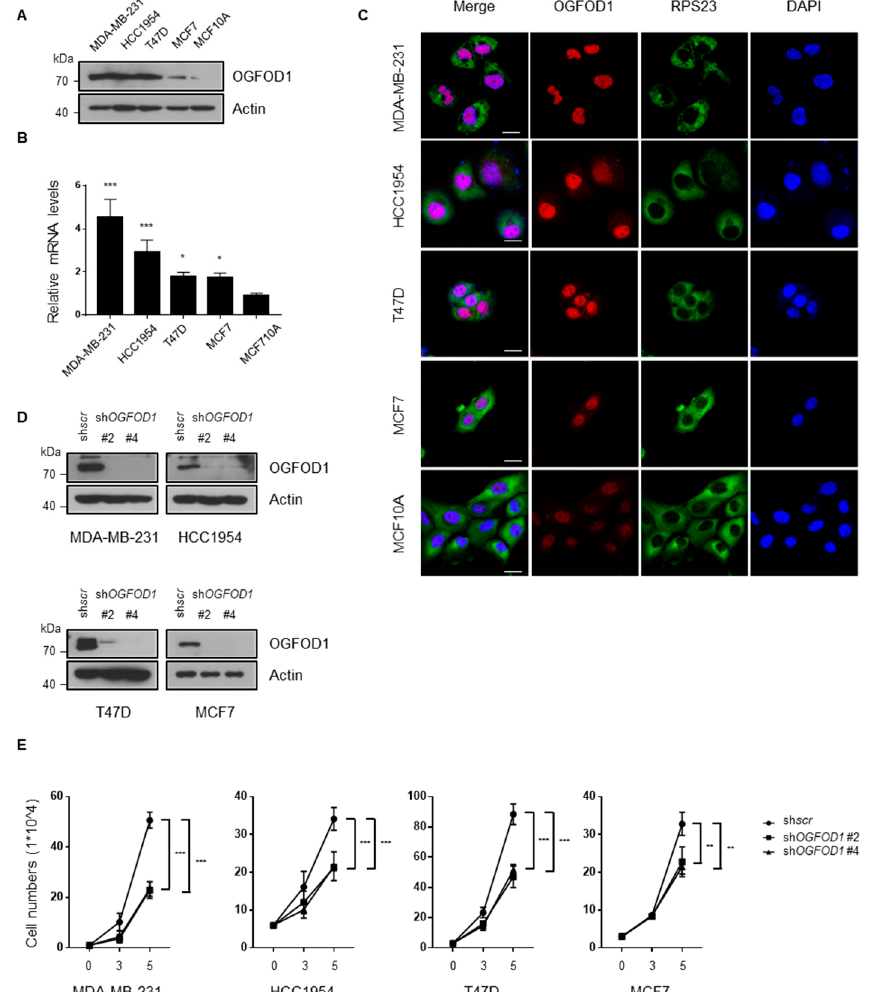
Figure 1. High level of OGFOD1 is important for proliferation. ( A , B ) Protein and mRNA levels of OGFOD1 in breast cancer cell lines and non-tumorigenic epithelial cell line. Protein levels were confirmed using Western blot assay. mRNA levels were compared using qRT-PCR. ( C ) Confocal images of OGFOD1 and RPS23 in breast cancer cell lines. OGFOD1 was stained with Alexa 568 (red), RPS23 was stained with Alexa 488 (green) and nuclei were stained with DAPI (blue); scale bar indicates 20 µ m. ( D ) OGFOD1 knockdown in breast cancer cell lines. OGFOD1 was knocked down using lentiviral sh RNAs and was validated. shs cr was treated as a negative control. ( E ) Proliferation rate of breast cancer cell lines. Statistical data are presented as mean ± SD. Two-tailed unpaired Student’s t -test was conducted for statistical analysis ( n = 4) (* p < 0.05, ** p < 0.01, *** p <